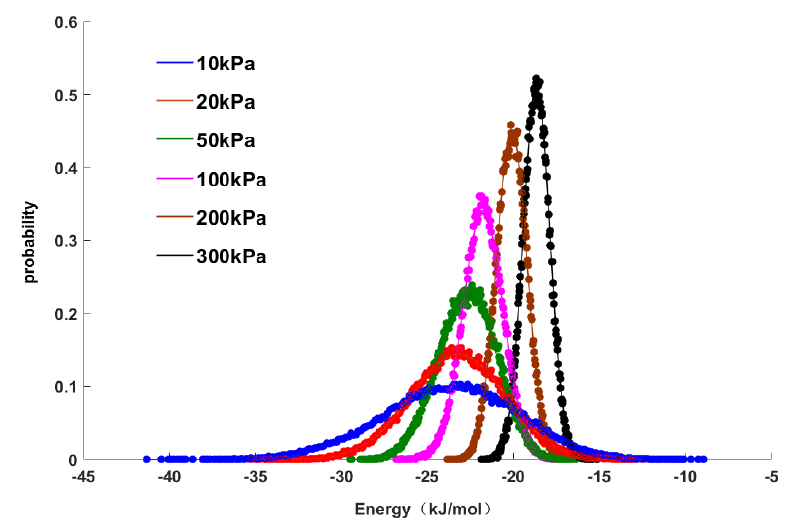
Figure 4. The adsorption energy distribution curves of CO 2 on MIL-101 (Cr) under different pressures.